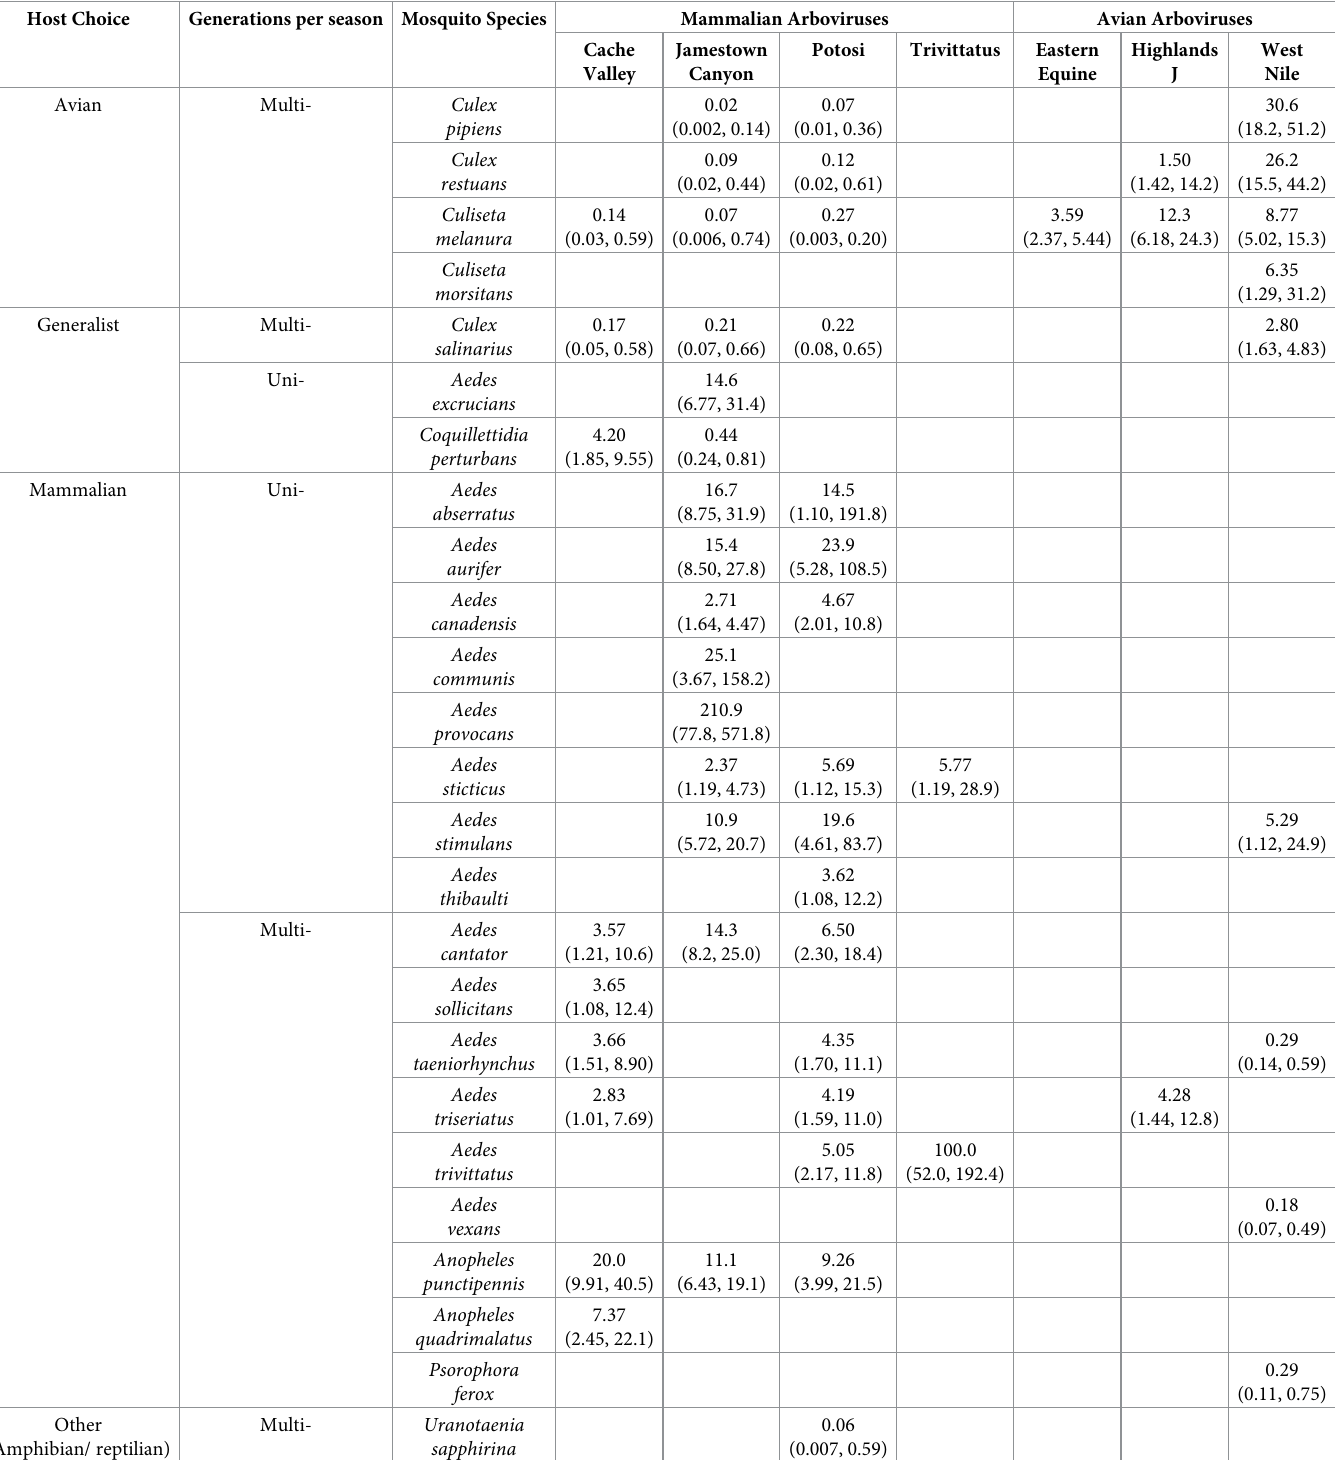
Table 1. Odds that a pool identified to a specific mosquito species tested positive for any of seven arboviruses circulating in Connecticut, U.S. from 2001–2018. Odds ratios were generated from arbovirus-specific binomial error generalized linear mixed effects models with infection status (1 –positive, 0 –negative) as the